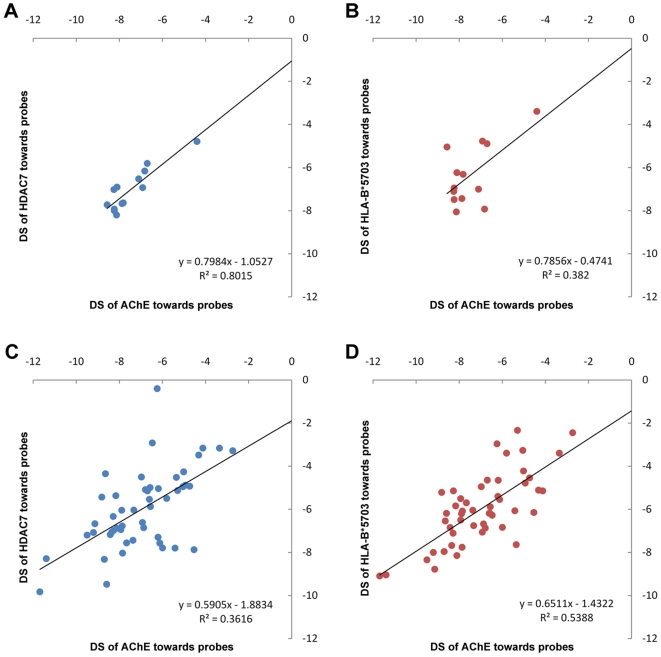
Correlations of docking scores among AChE, HDAC7 and HLA-B*5703 towards probe molecules.The assumed normality and equal variances of docking scores within each group could not be rejectedin statistical tests. The PDB ID of the representative structures of AChE, HDAC7 and HLA-B*5703 were 1F8U, 3Z0Y and 2BVP respectively. See Table S2 for the detail of their interactomes. (a, b) Correlations of docking scores among AChE, HDAC7 and HLA-B*5703 towards 13 probe molecules. (c, d) Correlations of docking scores among these three proteins toward 50 control probes.